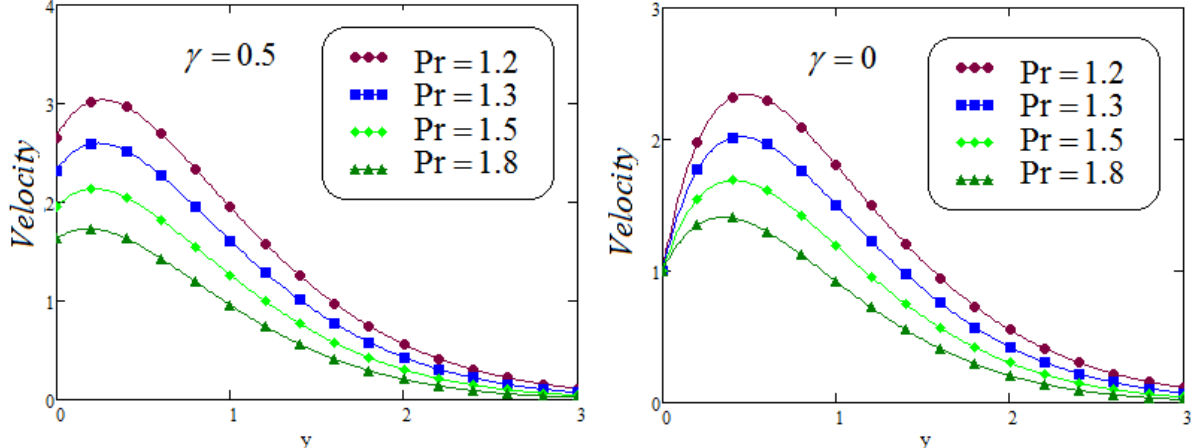
Figure 8. Velocity field under slip conditions as well as the velocity field under no-slip conditions for different Pr values when f ( t ) = sint , t = 1.5, Gr = 3.5, λ 1 = 0.6, λ 2 = 0.2, M =